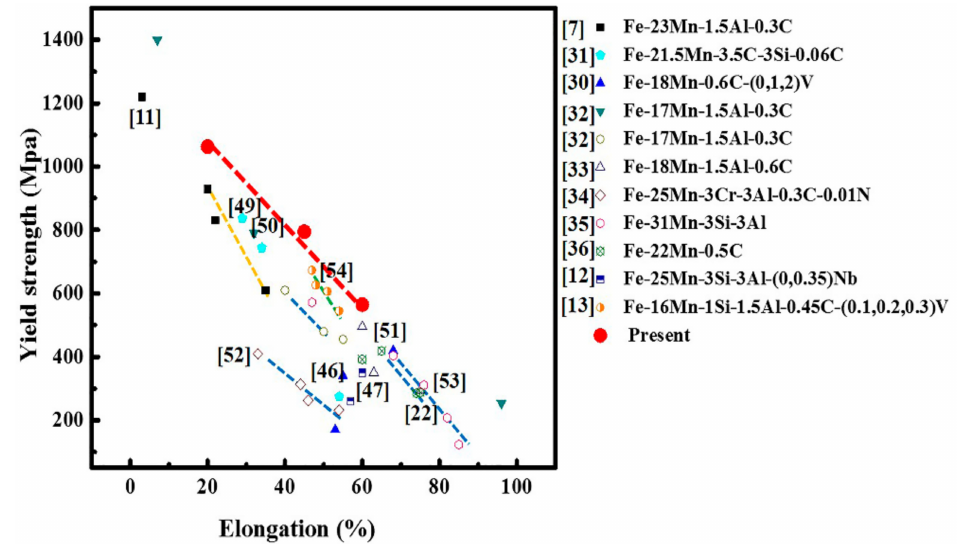
Figure 11. Comparison between the present TRIP/TWIP steel and previous